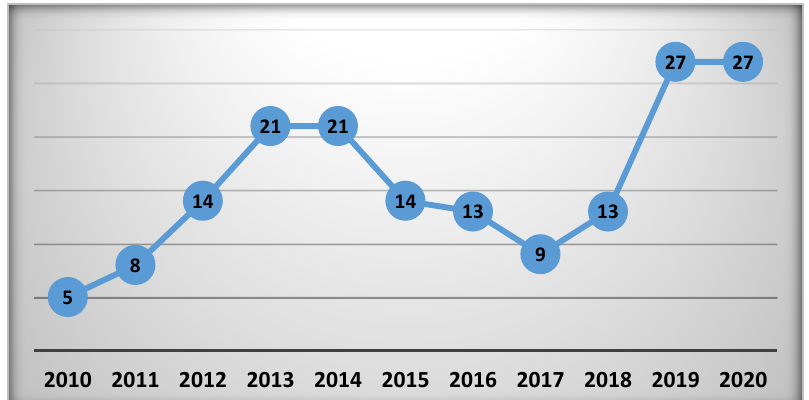
Fig. 3. Number of HFS articles according to years